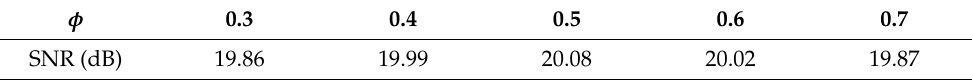
Table 1. The variations of the SNR with respect to the different loss function weights φ